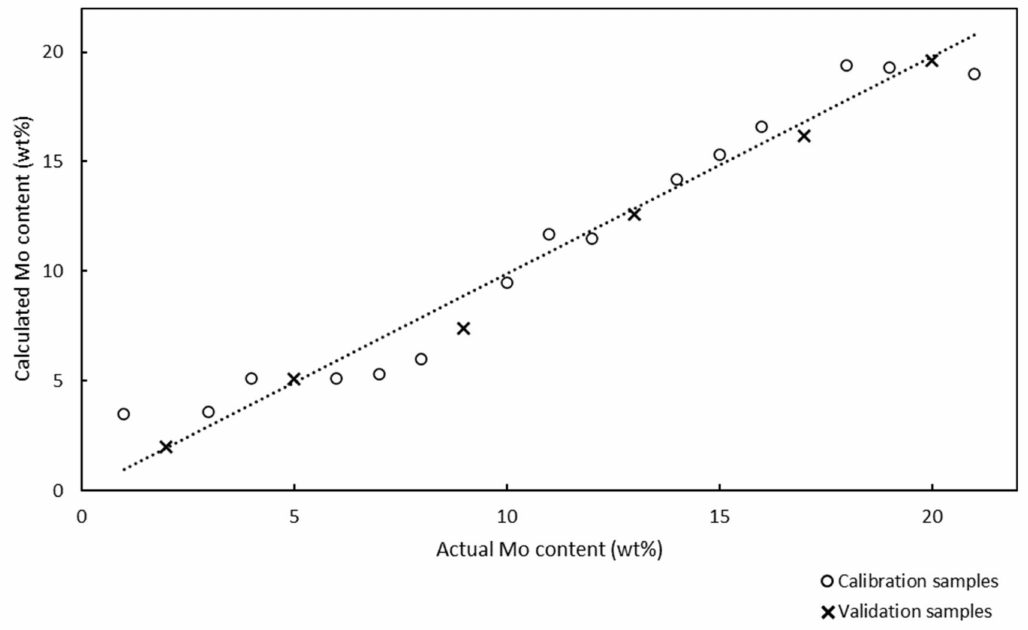
Figure 9. Raman model for the quantitative analysis of Mo-supported beta zeolite catalysts with Mo contents in the range of 1–21 wt%. Correlation coe ffi cient: 0.9777, two factors used. The circles and × marks represent the calcinated calibration and validation samples, respectively. Electronic supplementary material, Table S3.